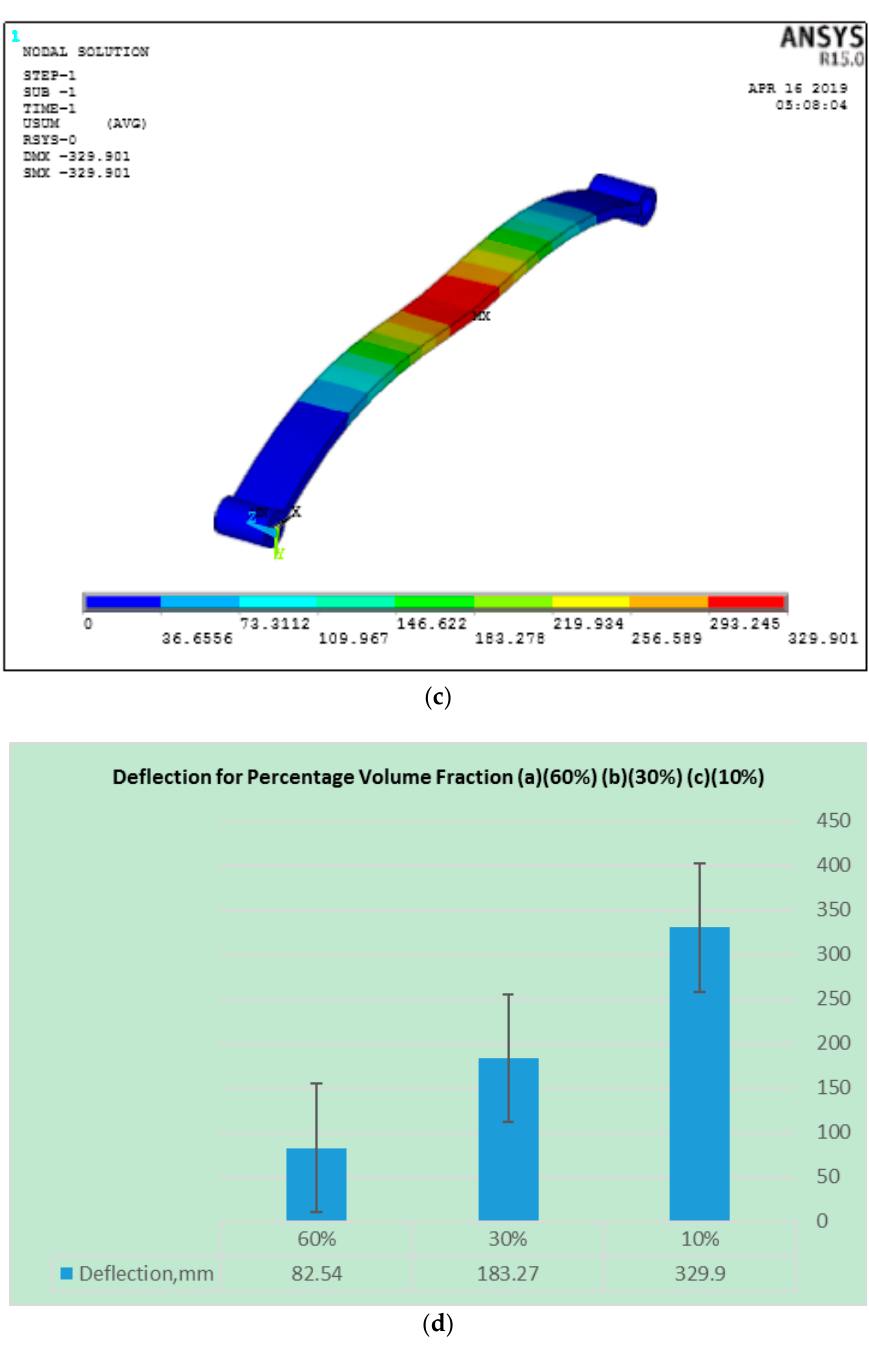
Figure 11. Deflection for percentage volume fraction at 0 Deg orientation only ( a ) 60% ( b ) 30% ( c ) 10% ( d ) deflections.